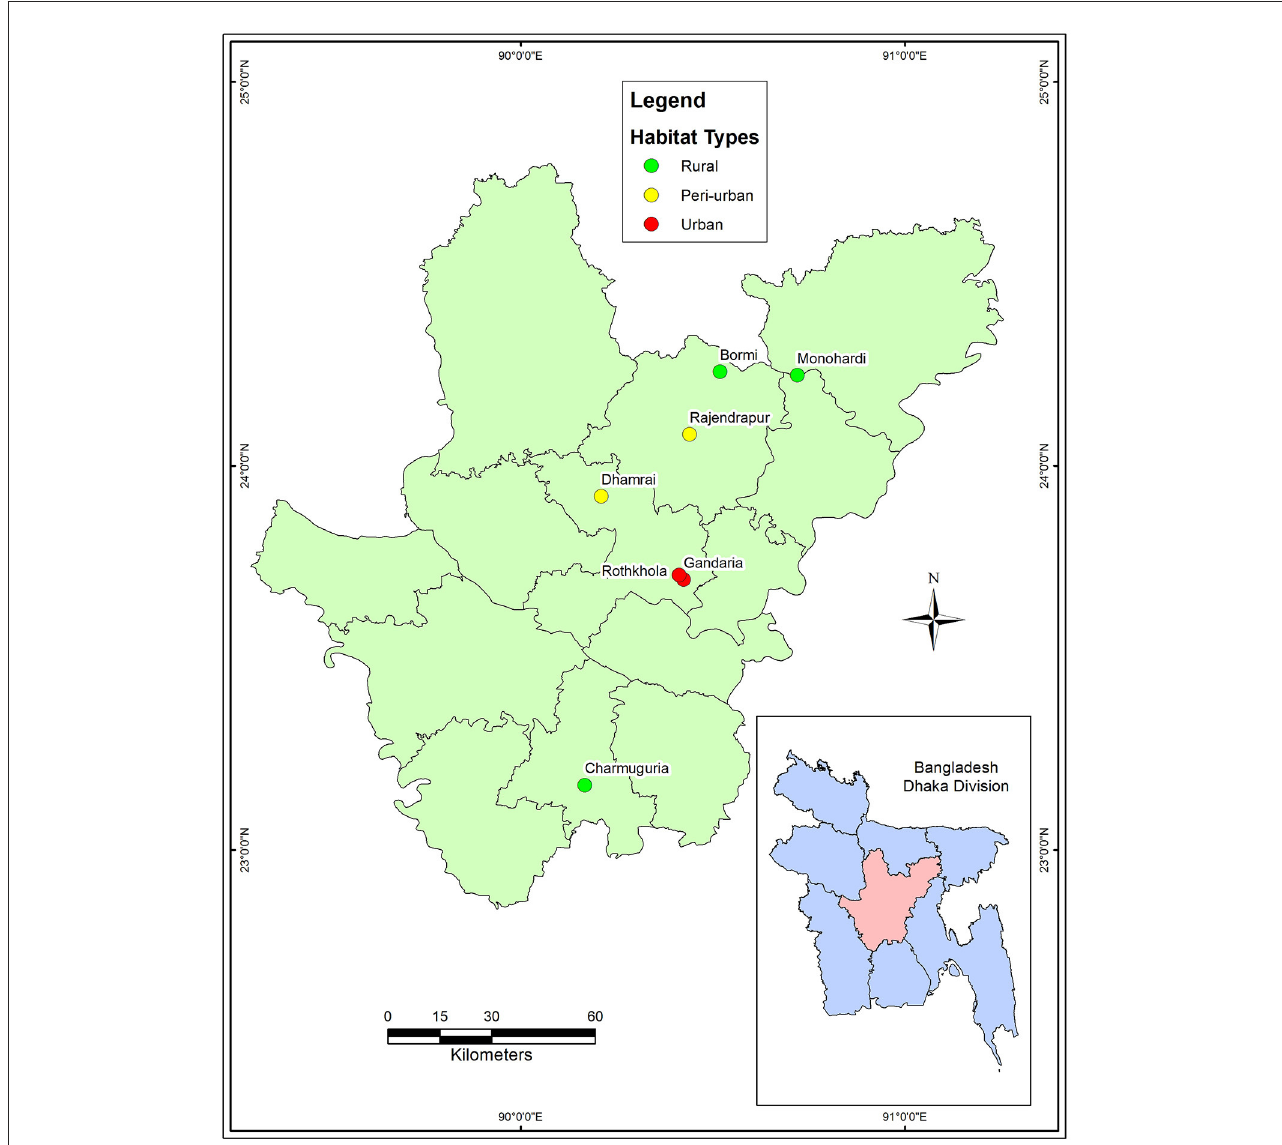
FIGURE1 Map showing the sampling